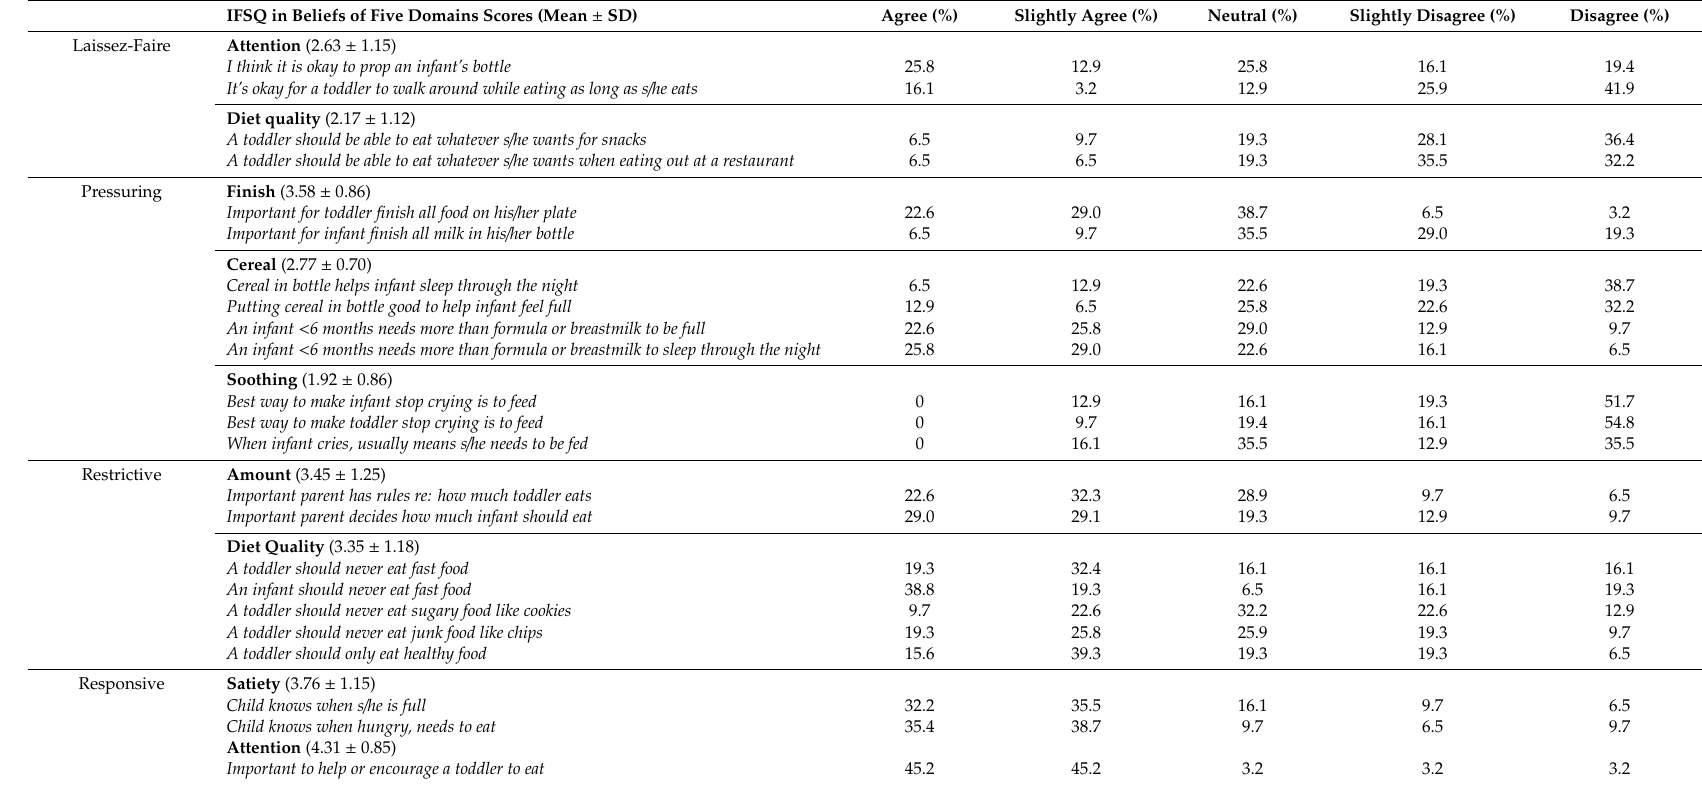
Table 3. IFSQ in beliefs of five domains scores ( n =